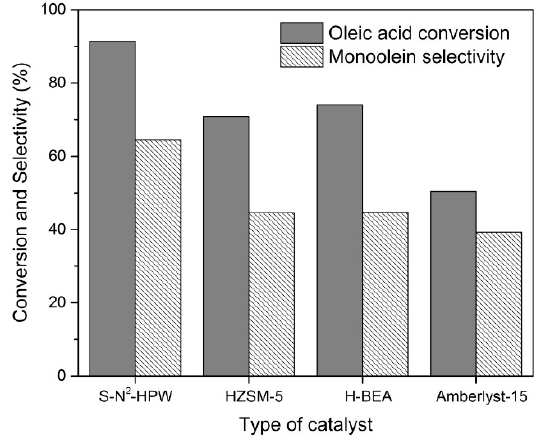
Figure 10. Comparison of catalytic performance of S-N 2 -HPW and three commercial acid catalysts: HZSM-5, H-BEA, and Amberlyst-15 for esterification of glycerol with oleic acid at 160 °C for 3 h using glycerol/oleic acid molar ratio of 4:1 and 2.5 wt % of catalyst loading.